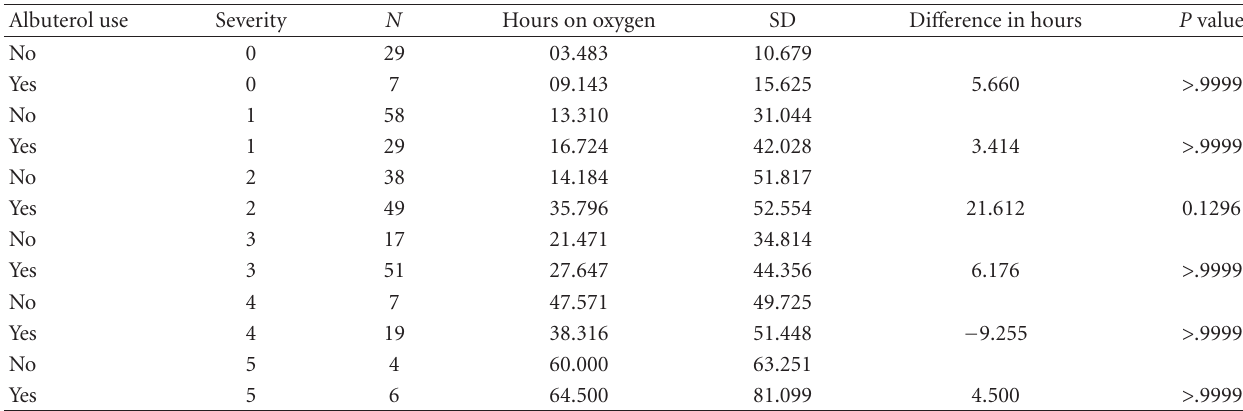
Table 2: Albuterol use, severity, and hours on oxygen.